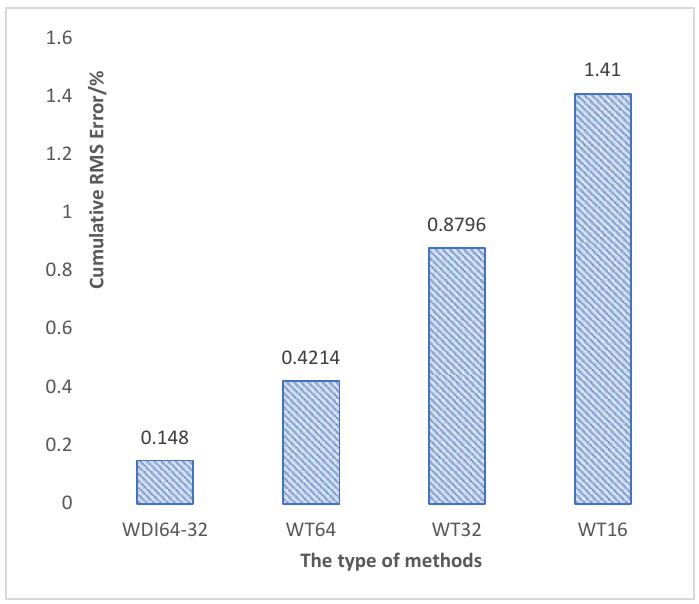
Figure 11. Cumulative RMS error of the WDI64-32, WT64, WT32 and WT16 methods. Figure 11 shows the cumulative RMS errors computed with the different algorithms.